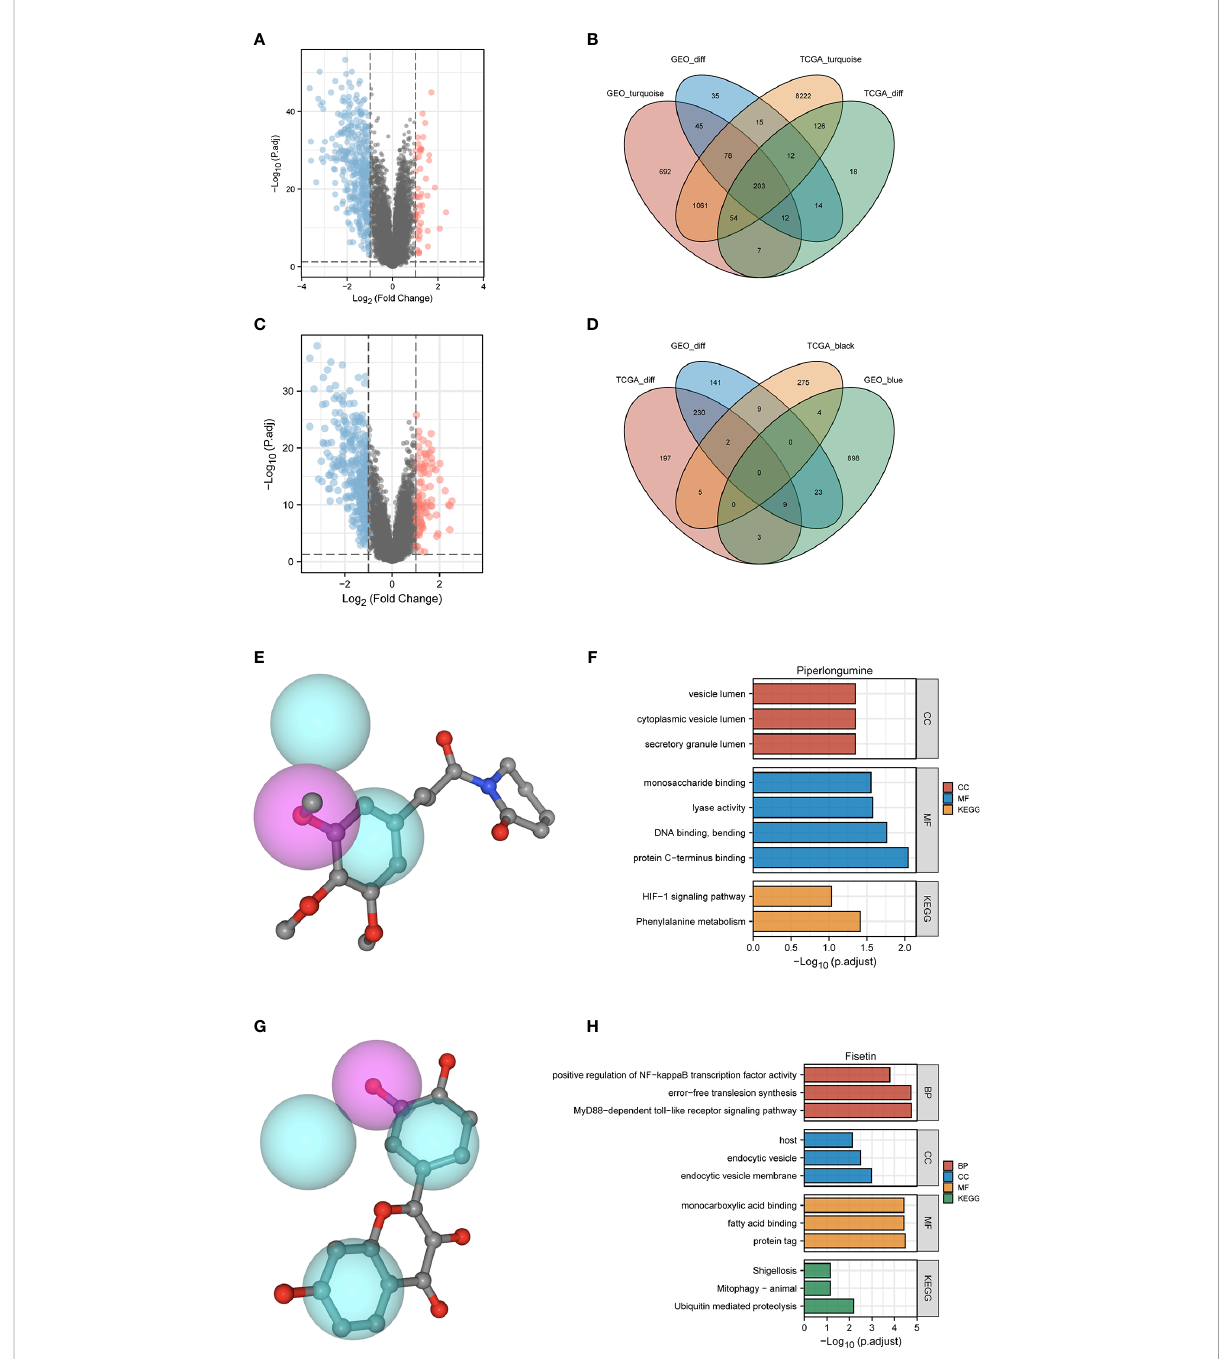
FIGURE 10 Potential small molecule compounds and function prediction. (A – D) . Differentially expressed genes were identi fi ed between low- and high-PYS groups in TCGA-HBV-LIHC (A) and GSE14520 (B) cohort, respectively. The Venn diagram for positive correlation (C) or negative correlation (D) with the low-PYS group. (E) The 3D structure diagrams of the pharmacophore for piperlongumine. (F) GO and KEGG for target genes of piperlongumine (G) The 3D structure diagrams of the pharmacophore for fi estin. (H) GO and KEGG for target genes of fi estin. DEGs: differently expressed